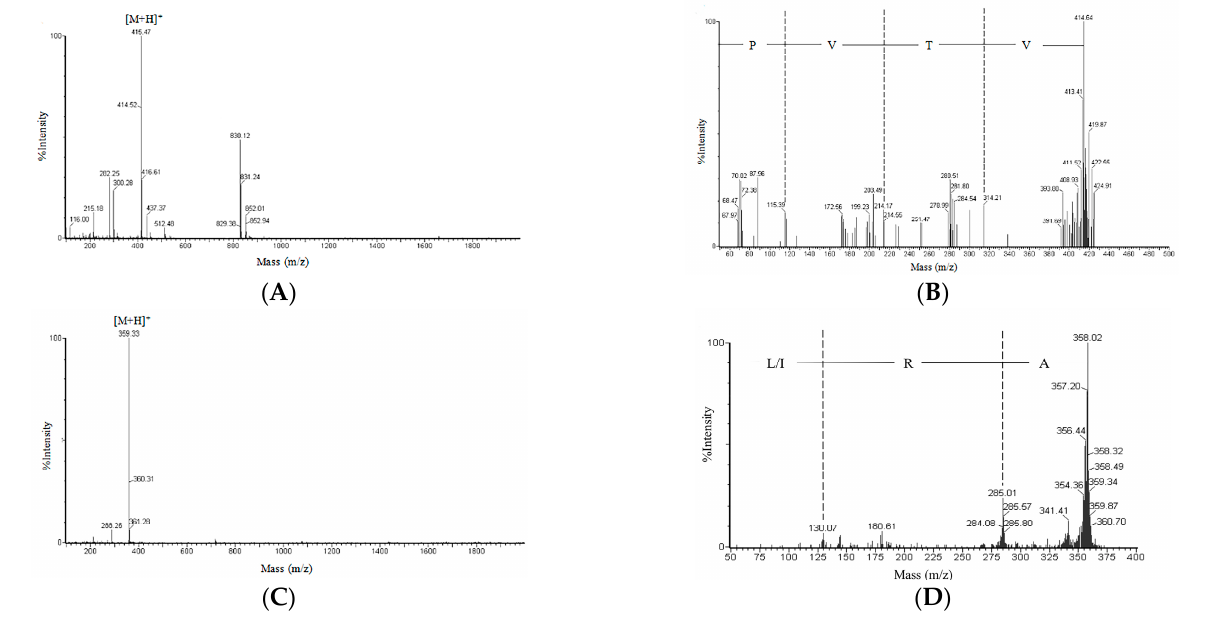
Figure 4. Identification of the molecular mass and amino acid sequence of active peptide fractions.